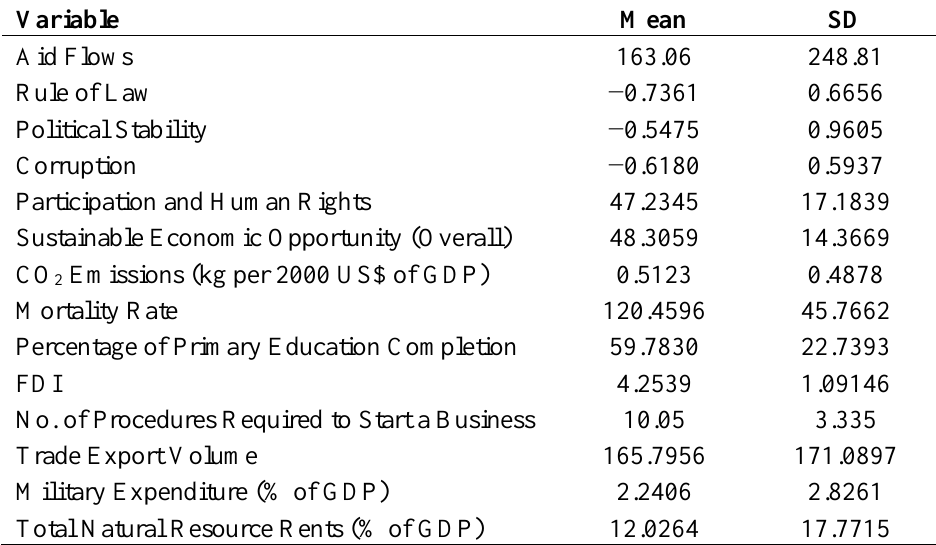
Table B1. Mean and standard deviation (SD) for each variables.